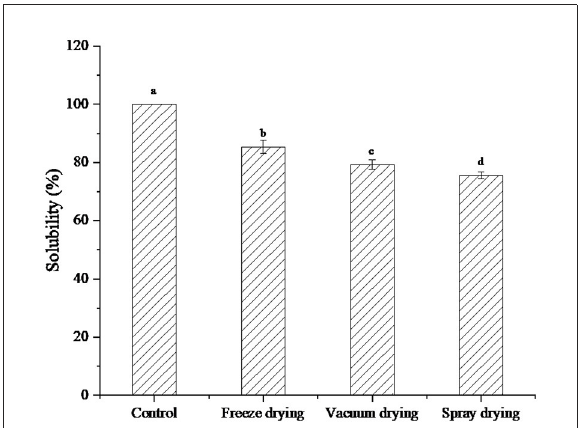
FIGURE2 Solubility of protein peptide powder by three dry methods. Different letters express significant differences ( p < 0.05).